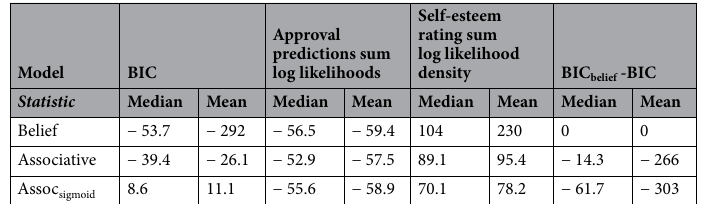
Table 4. Out-of-sample replication of model-comparison (‘confirmation’